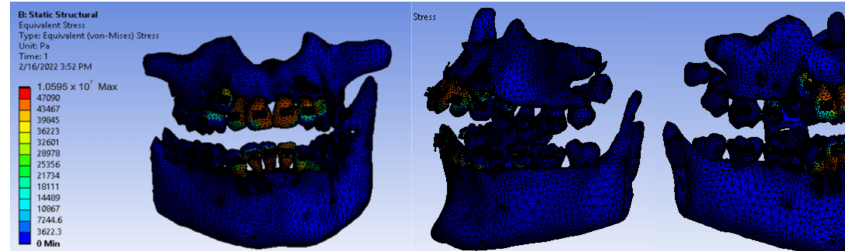
Figure 29. Deformation maps.